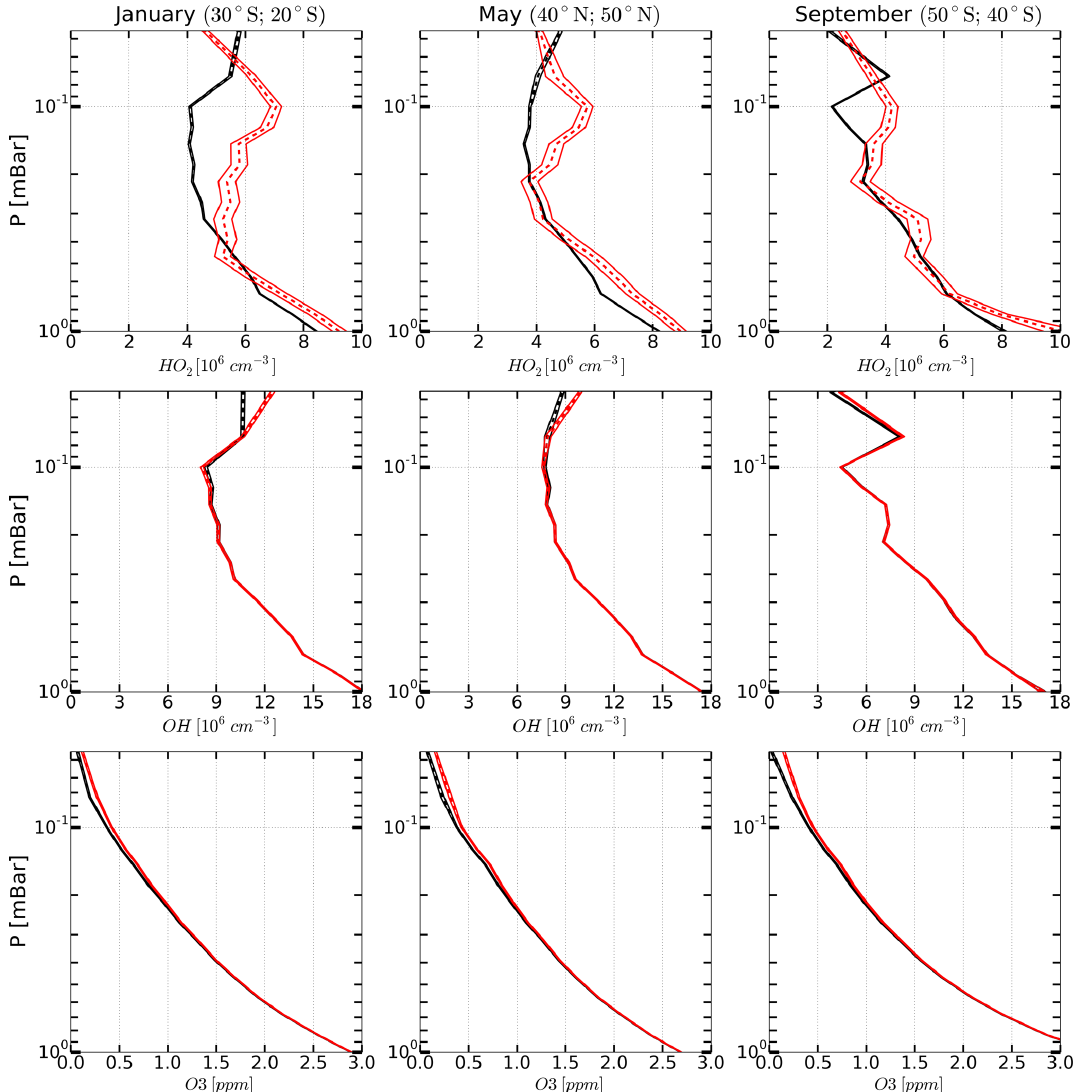
Figure 5. Examples of monthly averaged zonal mean vertical profiles of OH, HO 2 , and O 3 measured (red curves) in January, May, and March 2005 and corresponding retrieved profiles (black curves). Solid curves: boundaries of the 65% confidence intervals, dashed curves: